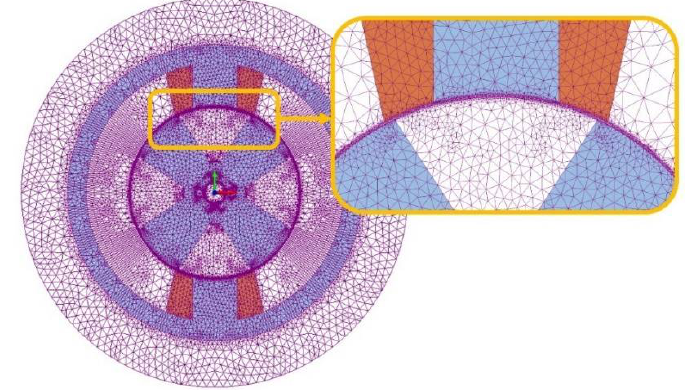
Figure 9. SRM’s 2D FE model for one phase.